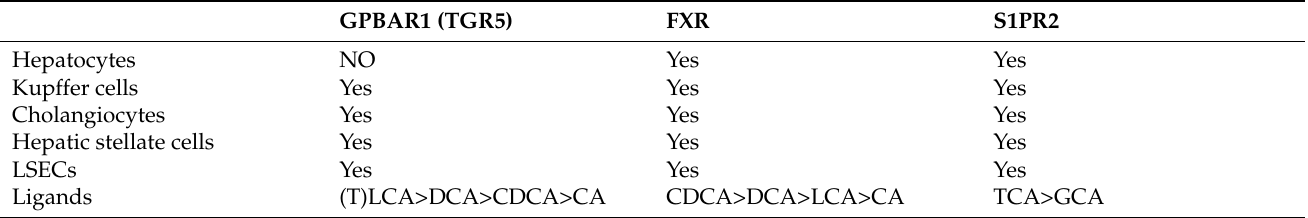
Table 1. Selected bile acid receptor expression in the liver and activation by bile